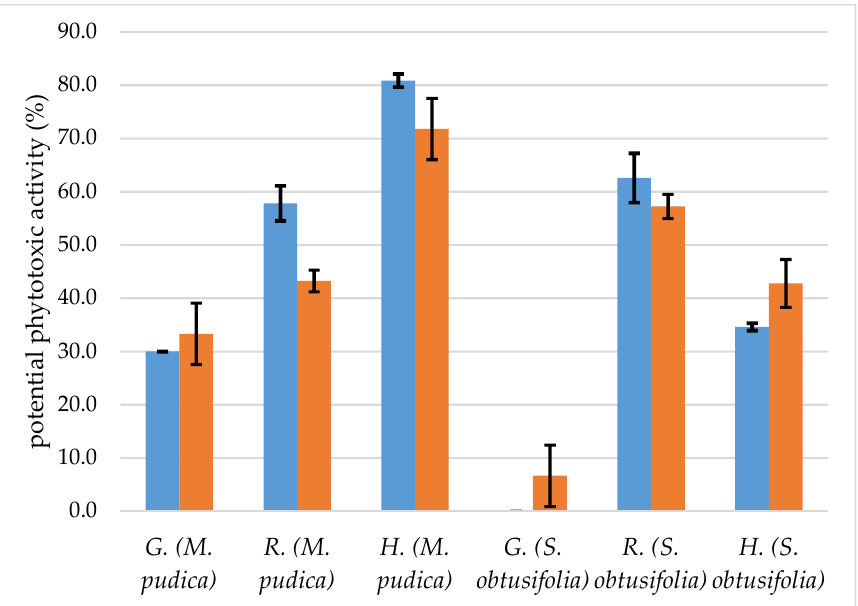
Figure 1. ABTS •+ and DPPH • radical scavenging assay e Trolox equivalent antioxidant capacity de Calycolpus goetheanus . Values are expressed as mean and standard deviation ( n = 3) of Trolox equivalent antioxidant capacity. The ABTS •+ and DPPH • Radical Scavenging Assay (ABTS •+ ; DPPH •